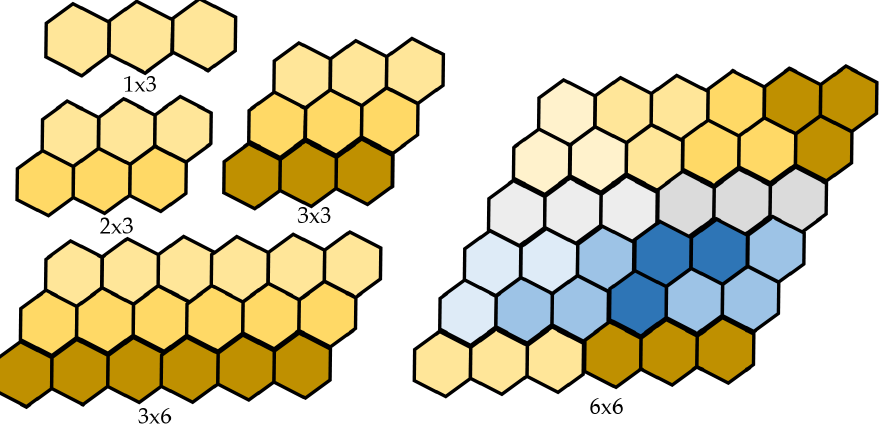
Figure 6. hTrihex covers the workspace by tileset.